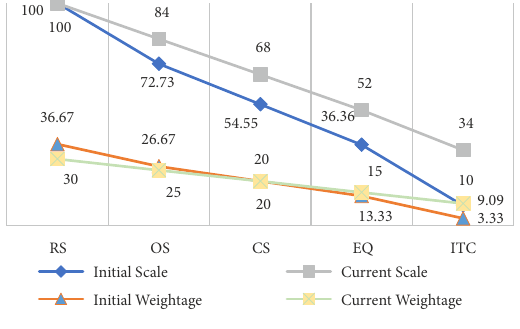
Figure A3. Model modification for value-added criteria Figure A4. Model modification for desirable criteria